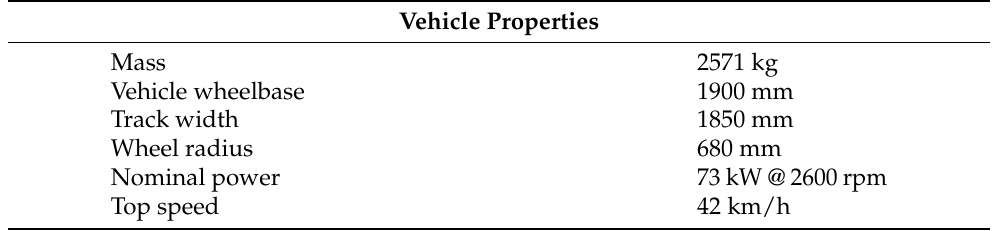
Table 1. Main characteristics of the orchard tractor.